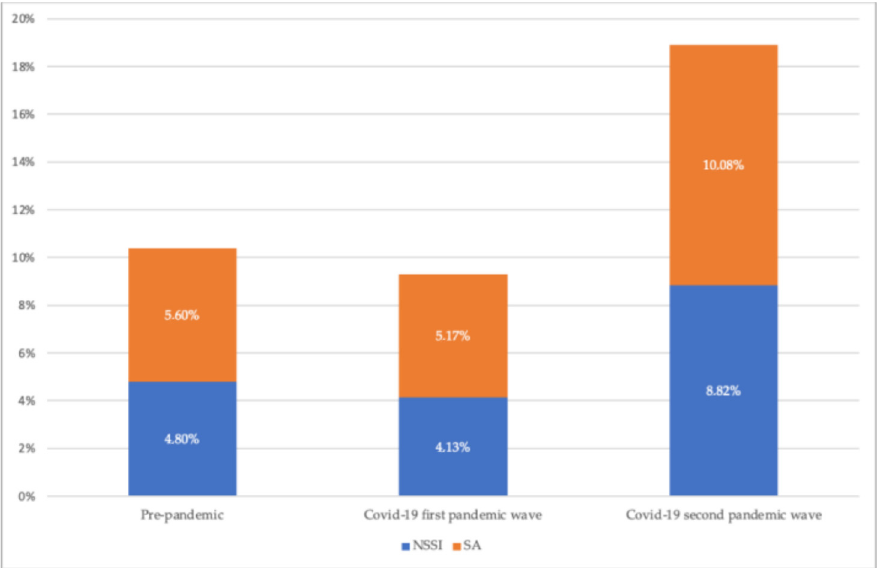
Figure 1. Reciprocal ratio between SA and NSSI.